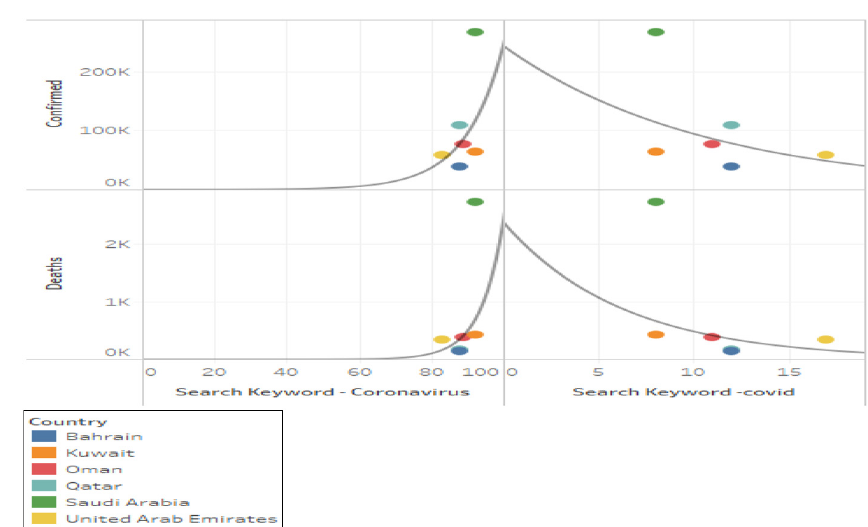
Figure 13. Con fi rmed cases and deaths vs search term